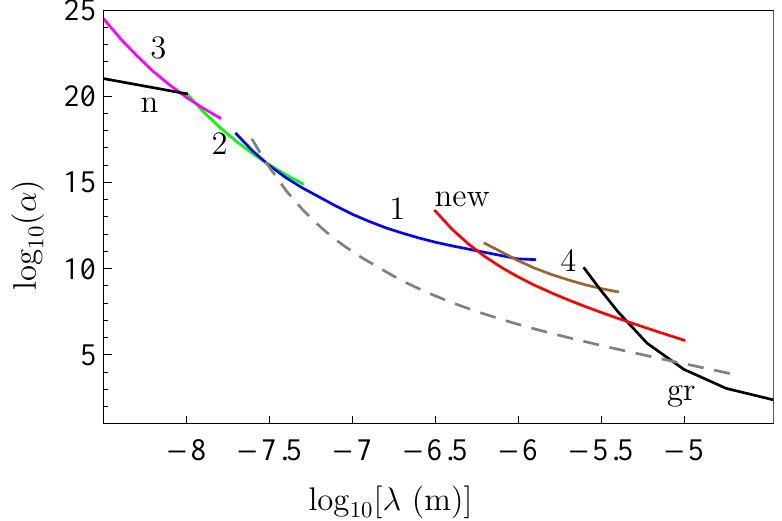
Figure 2. The strongest constraints on the interaction constant and interaction range of the Yukawa- type interaction obtained from different experiments. Lines 1, 2 and 3 are found from measuring the effective Casimir pressure between two parallel plates, and normal and lateral Casimir forces between the sinusoidally corrugated surfaces of a sphere and a plate, respectively. The line labeled “n” is found from the experiments on neutron scattering. The lines labeled “new” and 4 follow from the experiment measuring the Casimir force in the micrometer separation range and from the experiment using a torsion pendulum. The line labeled “gr” and the dashed line are obtained from the Cavendish-type experiments and from the experiment nullifying the Casimir force. The regions above each line are excluded, and those below each line are